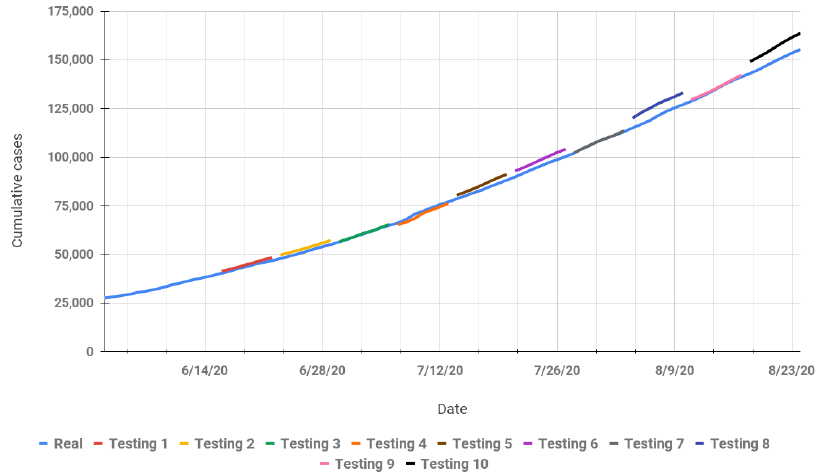
Figure 10. Actual and short-term forecasting for cumulative COVID-19 cases using the RNN model.